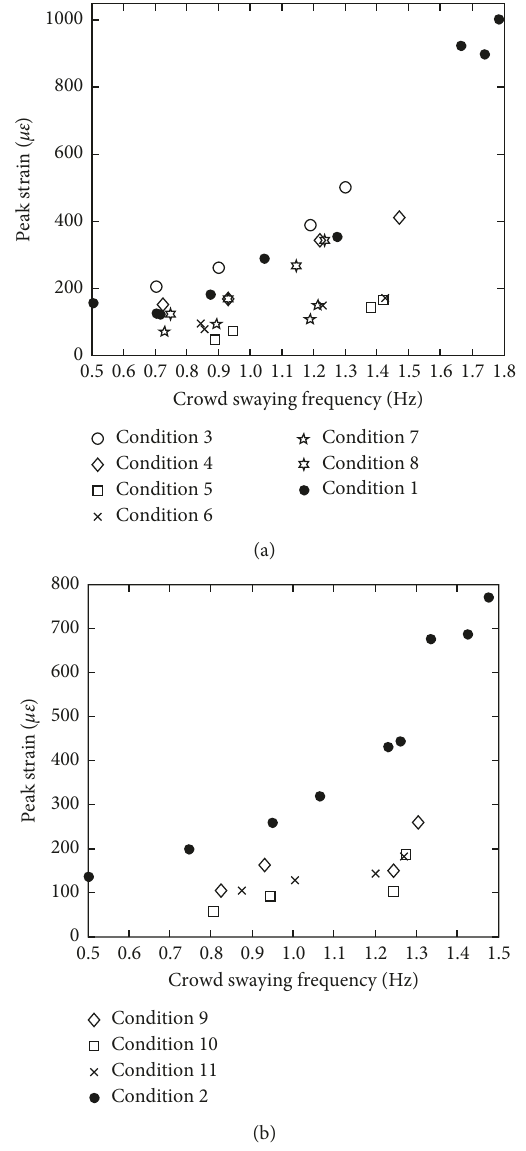
Figure 12: The maximum structural strains at different crowds swaying. (a) Standing crowd swaying and (b) seated crowd